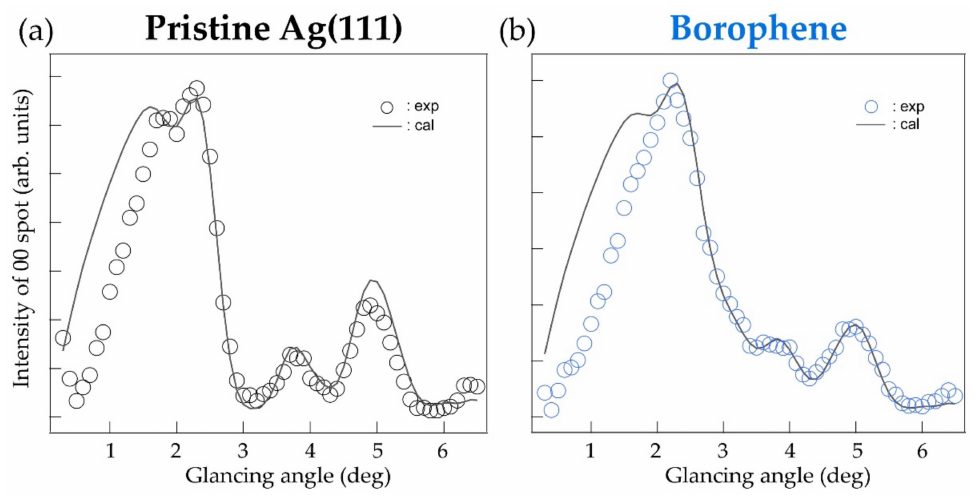
Figure 4. Rocking curve under many-beam (MB) condition with calculated curves for ( a ) pristine Ag(111) and ( b ) χ 3 -borophene on Ag(111).